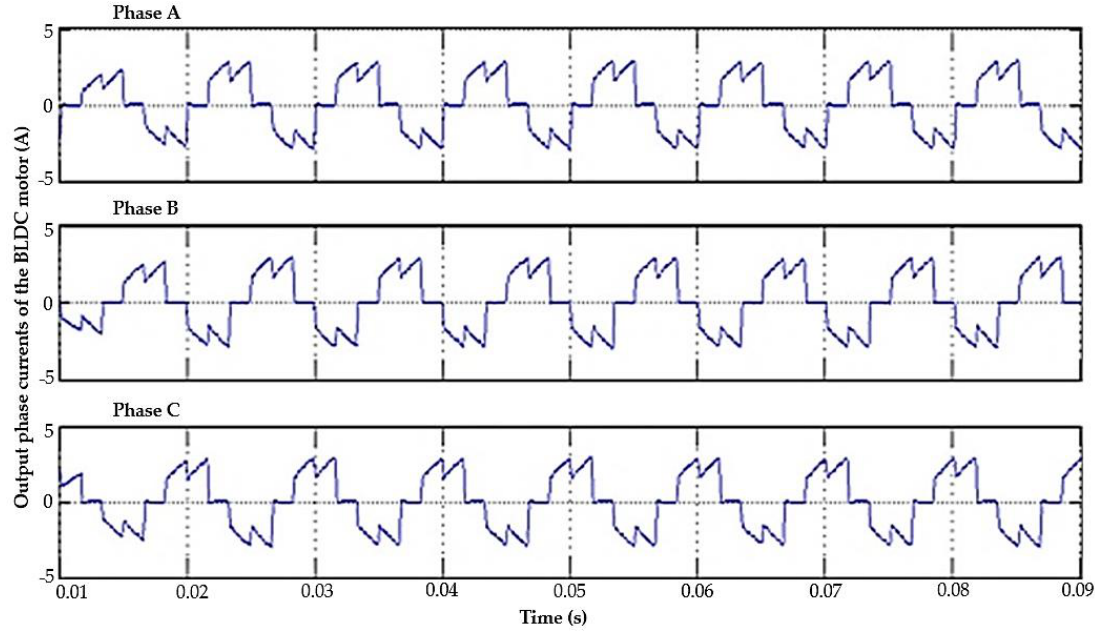
Figure 8. Output current waveform of the brushless DC (BLDC) motor.